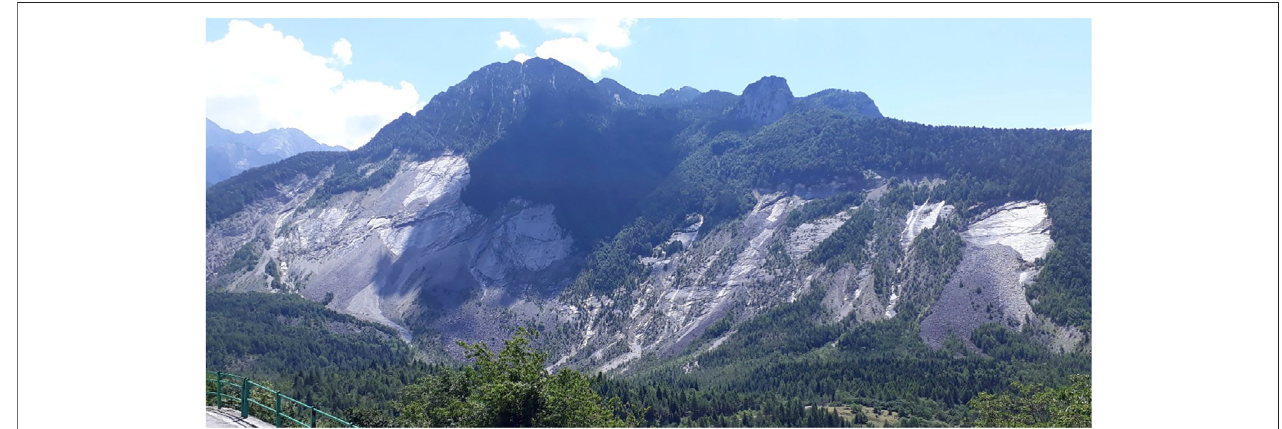
FIGURE 4 | Perspective view of the extensive scarp of the Vajont landslide (photo by C. Morino).